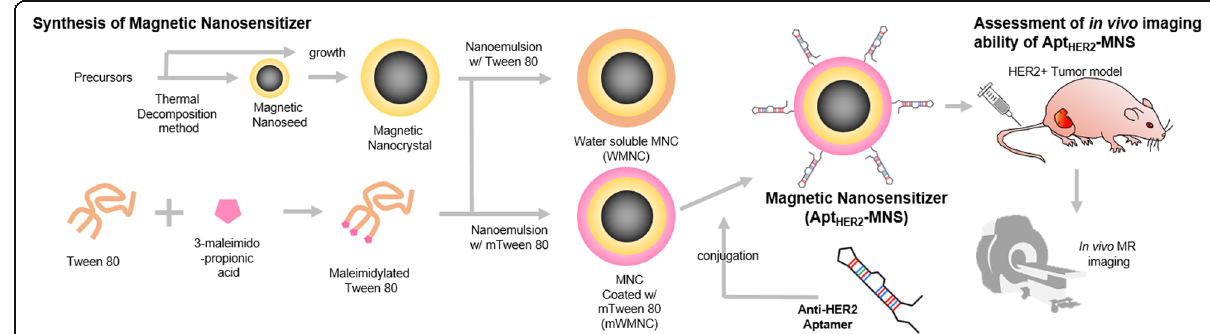
Fig. 1 Schematic illustration showing the experimental procedure for the preparation of aptamer-modified magnetic nanosensitizer (Apt HER2 -MNS) and their in vivo imaging ability